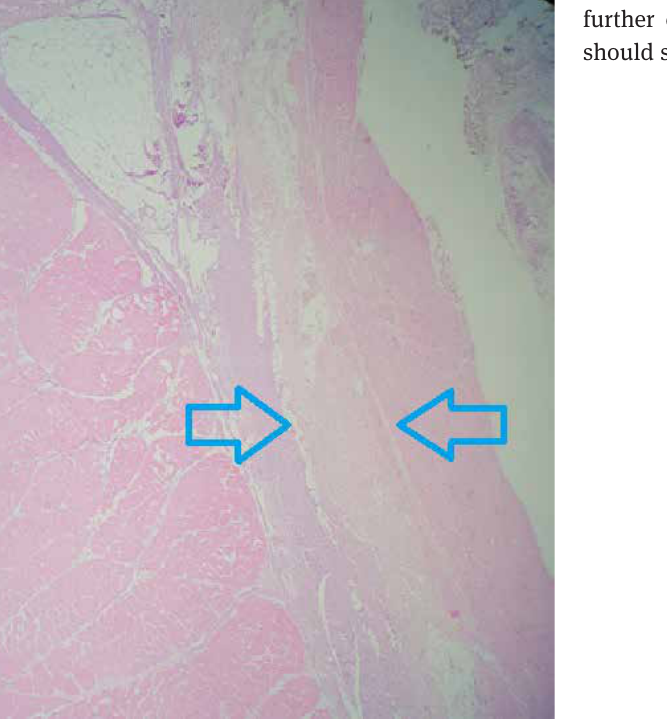
Figure 2: Sections stained with hematoxylin-eosin. Arrows indicate coagulated area